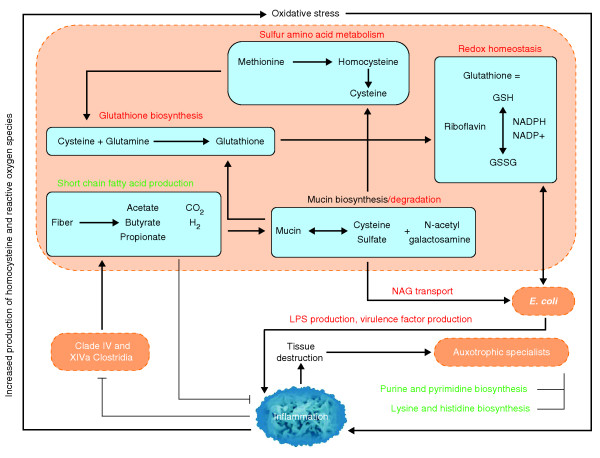
Proposed metabolic roles of the gut microbiome in IBD. Host-mediated processes (blue text) create an environment of oxidative stress in the intestine, which is more favorable to Enterobacteriaceae (increased abundance) than to clades IV and XIVa Clostridia (decreased abundance). This study's inferred IBD metagenomes include broadly increased oxidative metabolism, decreased SCFA production, and increased mucin degradation relative to healthy subjects. These processes all occur within microbes and rely on transport of small molecules to and from the lumen. The resulting tissue-destructive environment provides nutrients such as nucleotides and amino acids, which allow for increased growth of auxotrophic 'specialists'. Bacterial clades of interest are indicated in orange, bacterially mediated processes increased in IBD in red, and processes that decrease in green. Metabolic pathways differential in our IBD communities are contained in blue boxes. GSH and GSSG indicate reduced and oxidized forms of glutathione. LPS, lipopolysaccharide; NAG, N-acetyl galactosamine.